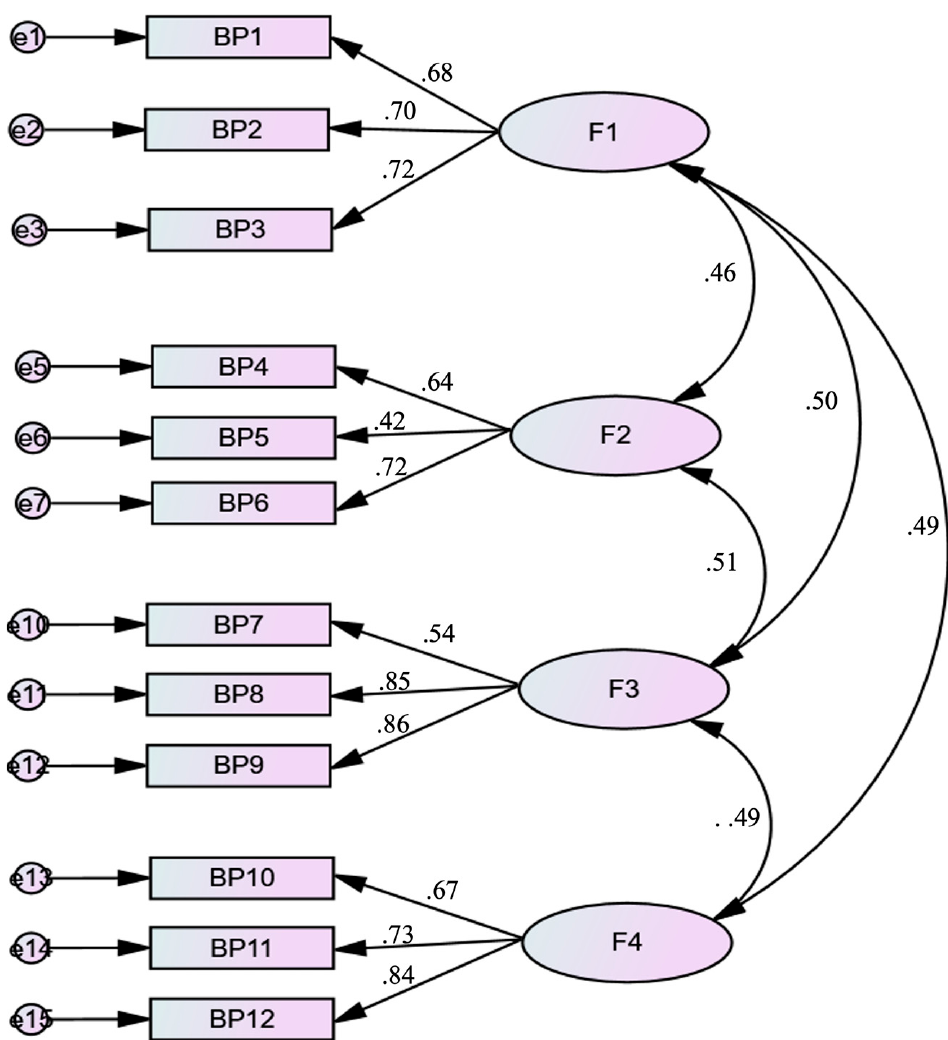
Figure 2. Standardized factor loadings of the four-factor model of the Arabic version of the Buss–Perry Aggression Questionnaire-Short Form ( p < 0.001 for all loading factors). F1= Physical aggression, F2 = Verbal aggression, F3 = Anger, F4 =